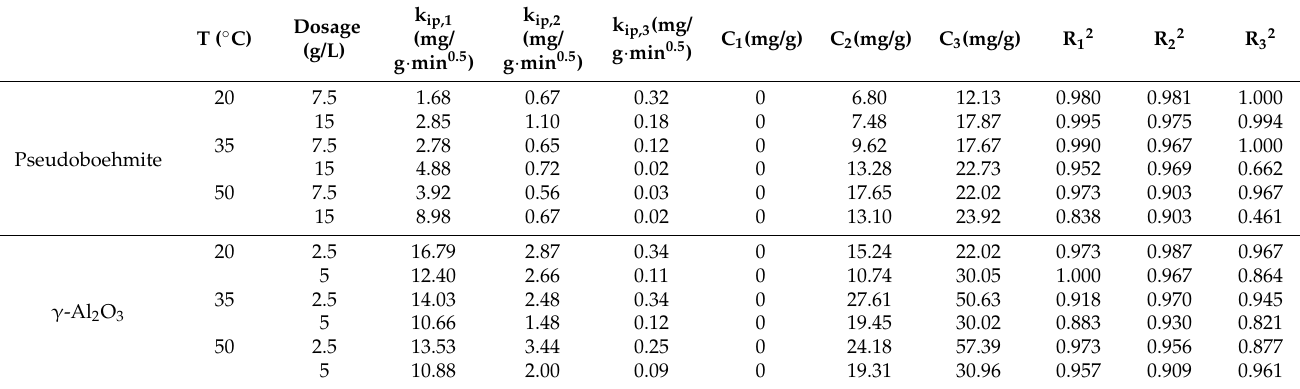
Table 5. Results from linear fits of the three main linear regions obtained after applying intra-particle diffusion model for pseudoboehmite and γ -Al 2 O 3 .